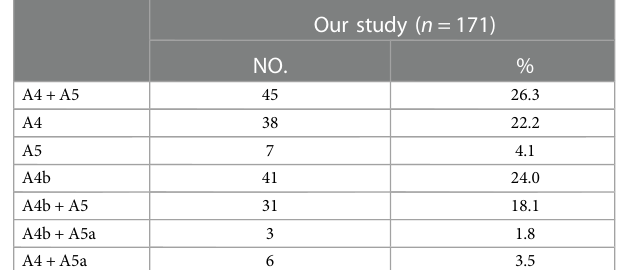
TABLE 5 The supplying range of the MLA.